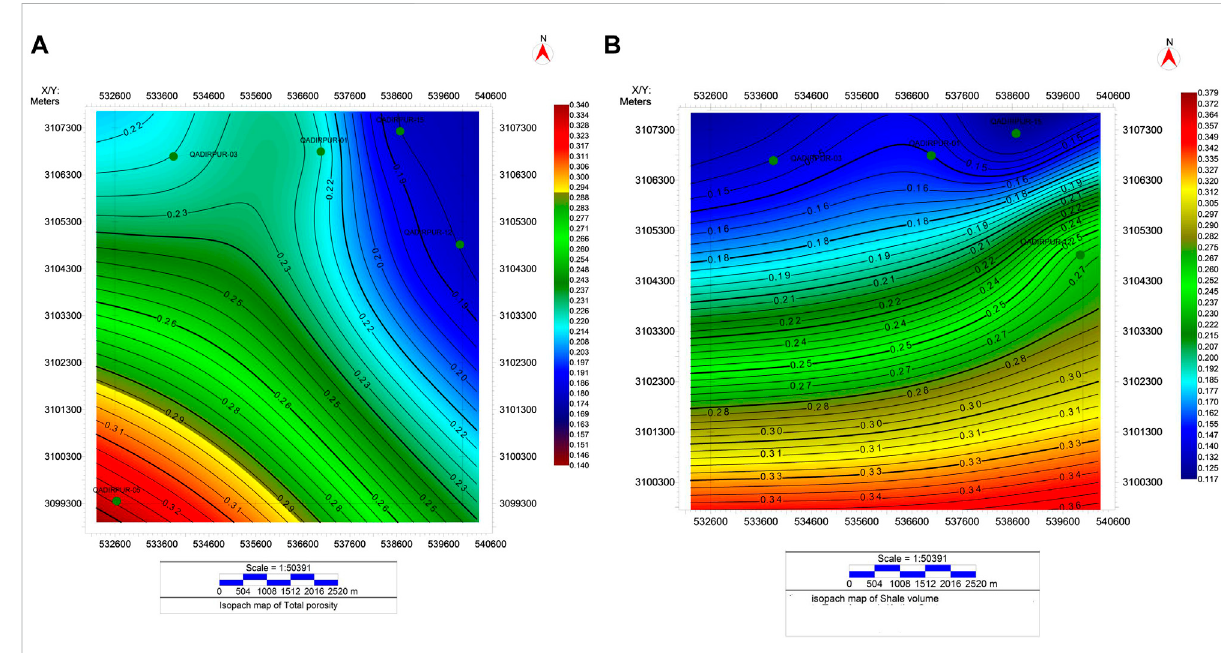
FIGURE 5 (A) Isopach map showing the total porosity distribution. (B) Volume of shale of Sui Main Limestone in the study